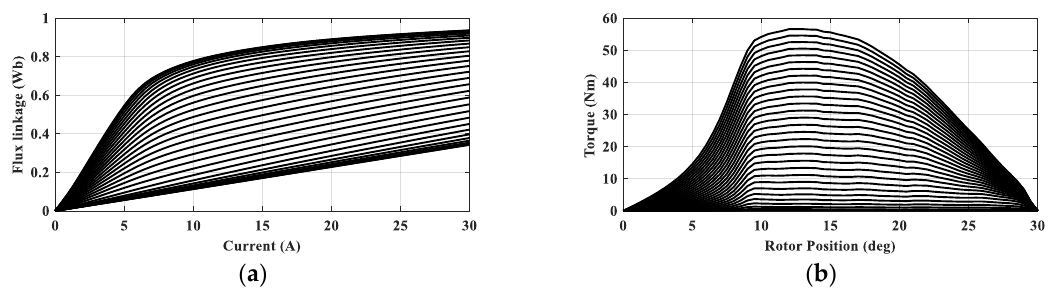
Figure 1. Simulation of one phase of SRM.